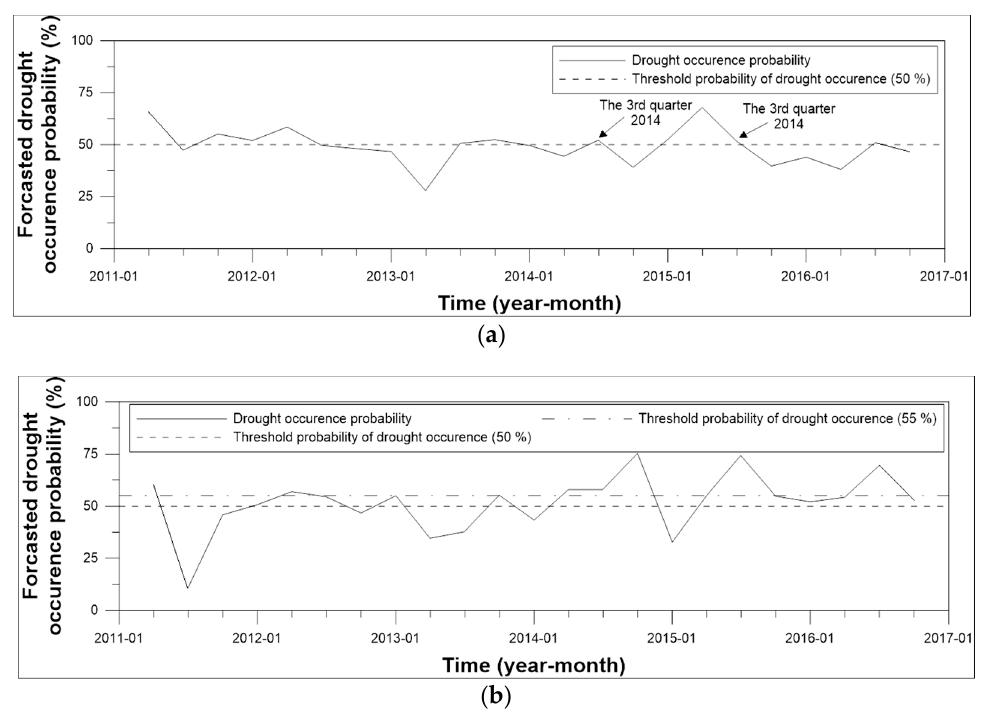
Figure 12. The results of quarterly drought forecast: ( a ) Soyanggang dam; ( b ) Andong dam.